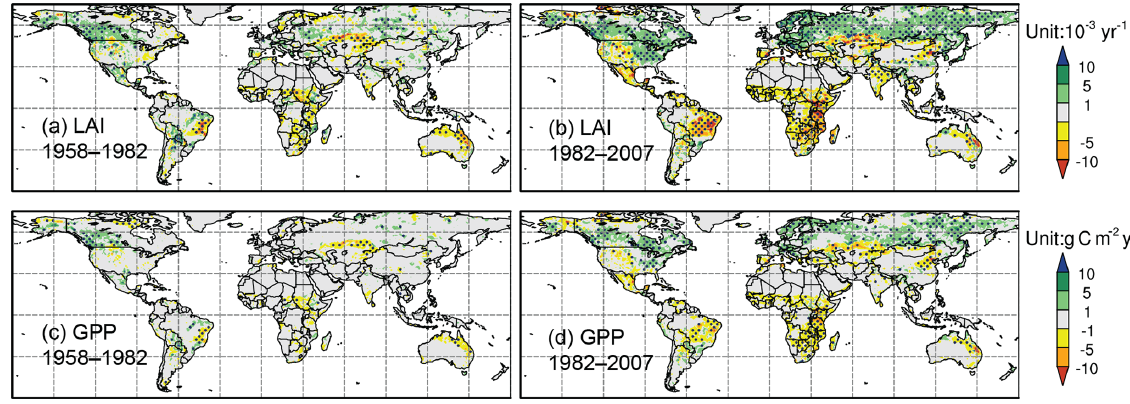
Figure 9. Same as Fig. 8 but for warming